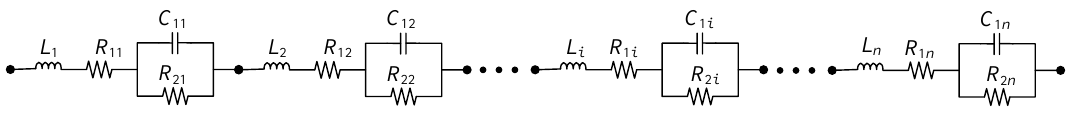
Figure 4. Equivalent circuit associated with complex conjugate pairs.